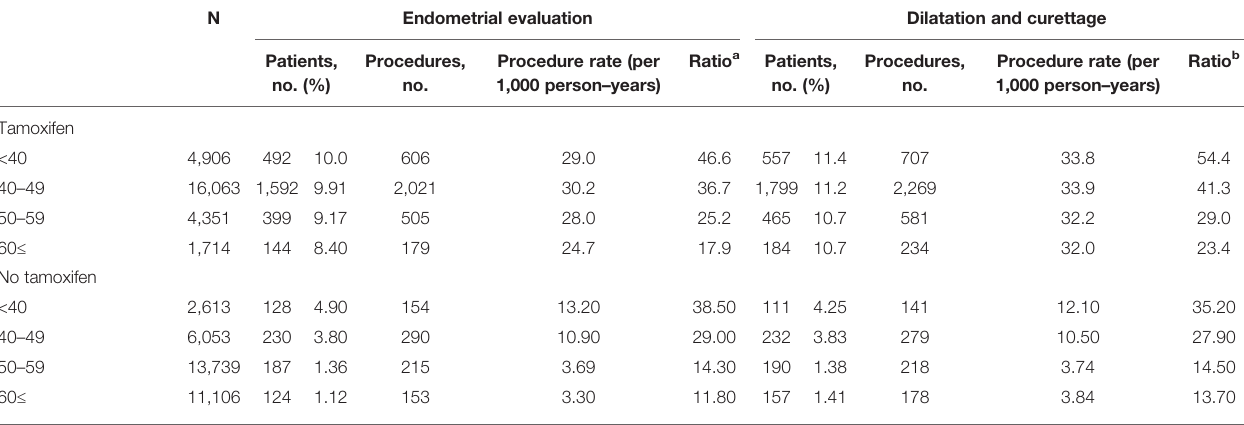
TABLE 4 | Frequencies of endometrial procedures in breast cancer survivors 1 year after initiation of treatment.